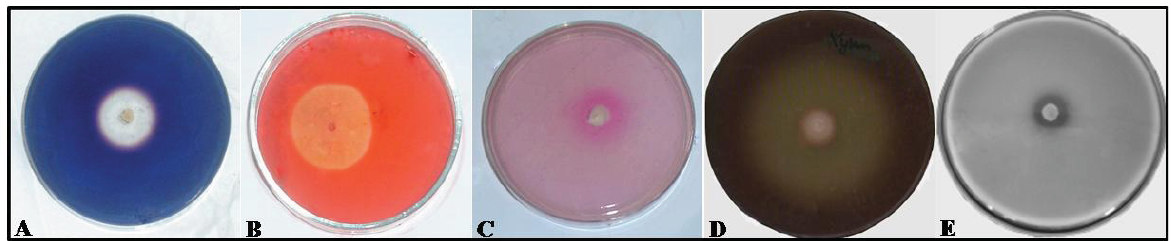
Figure S1. Polymer hydrolysis assays. Figure shows zones of hydrolysis of the tested polymers: ( A ) Amylase, produced by Pseudozyma sp. (ATT068); ( B ) CMCellulase, produced by Trichosporon montevideense (88c1); ( C ) Pectinase, produced by Pseudozyma sp. (ATT068); ( D ) Xylanase, produced by Cryptococcus cf. cellulolyticus (ATT064) and ( E ) Protease, produced by Pseudozyma sp.